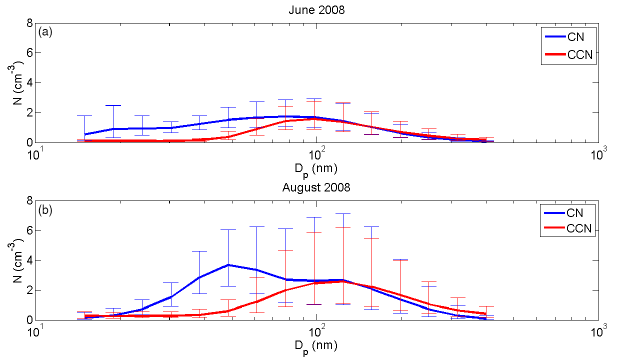
Figure 7. Geometric means of size-resolved particle density mea- surements and resulting CCN concentrations for the measurement period in (a) June 2008 and (b) August 2008. Measurements were conducted at 0.4% SS. Error bars indicate the geometric standard deviation.